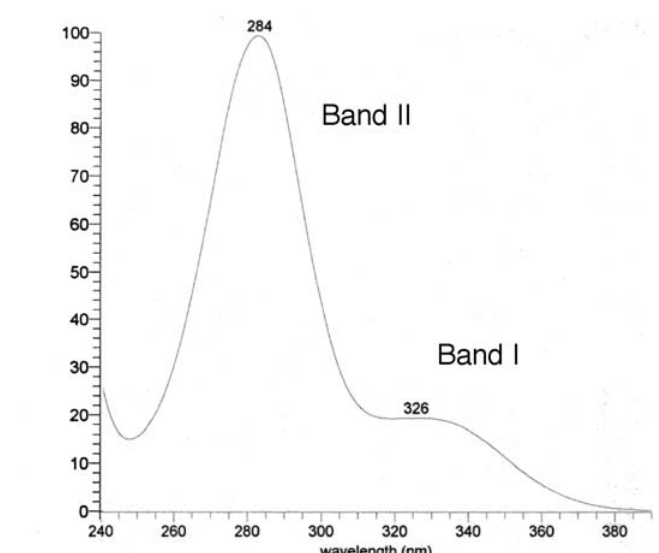
Figure 4. UV Spectrum of the flavanone hesperidin ( 23